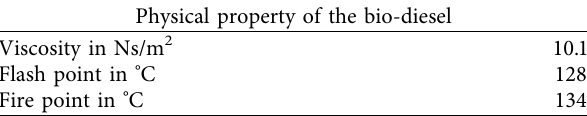
Table 3: Physical properties of the bio-diesel.